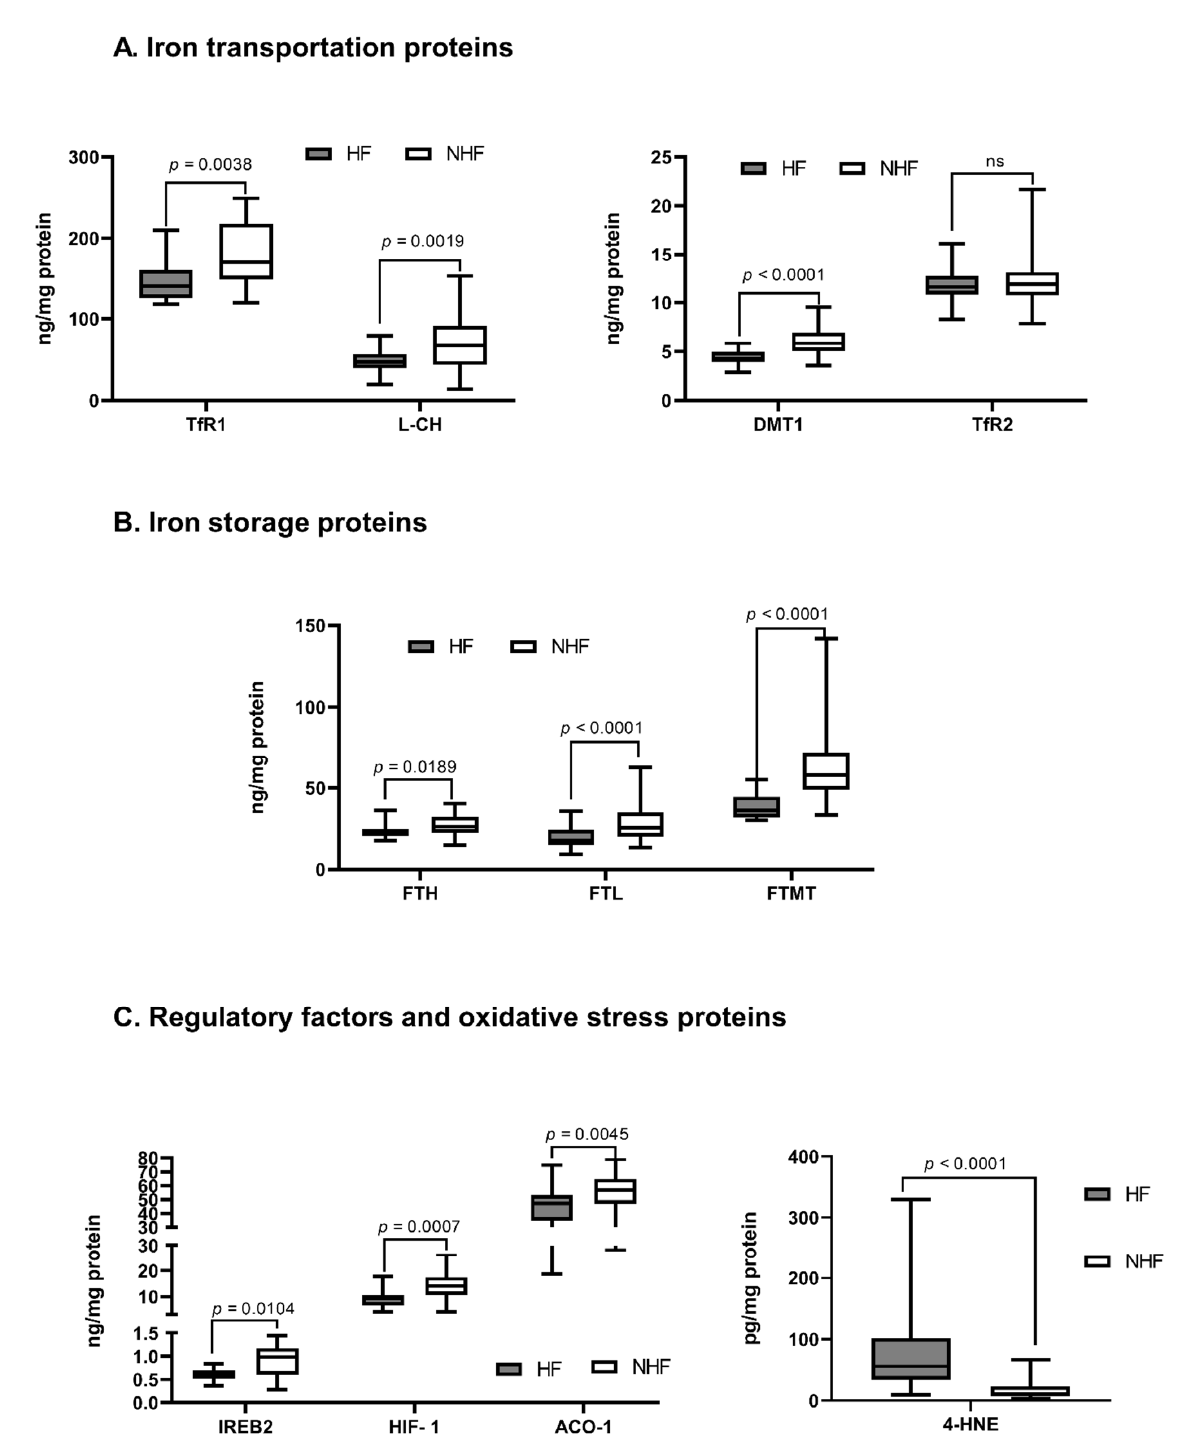
Figure 1. The concentration of iron metabolism proteins in the non-failing human myocardium. ( A )—Iron transportation proteins, ( B )—Iron storage proteins, ( C )—Regulatory factors and oxidative stress proteins. Only significant differences are shown; all results are presented in the supplement (Table S3); p—level of significance. Aberrations: HF (failing hearts), NHF (non-failing hearts), DMT-